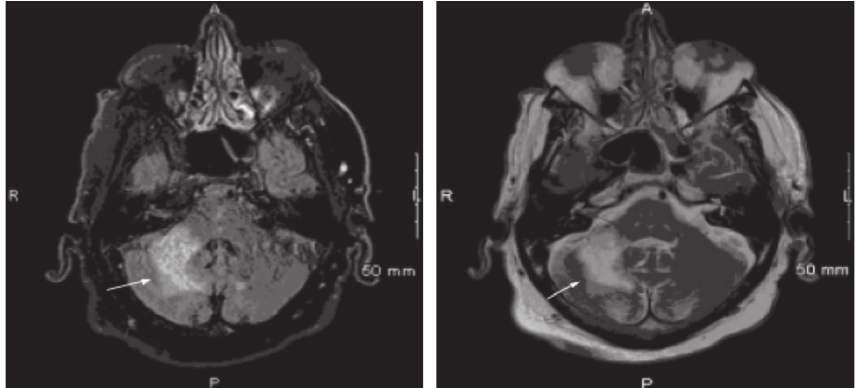
Figure 2: MRI showing interval increase in size of T2 and FLAIR hyperintense infiltrative signal intensity in the right middle cerebellar peduncle and right cerebellar hemisphere as well as a small new focus of FLAIR hyperintense signal intensity in the left cerebellar hemisphere parasagittal to